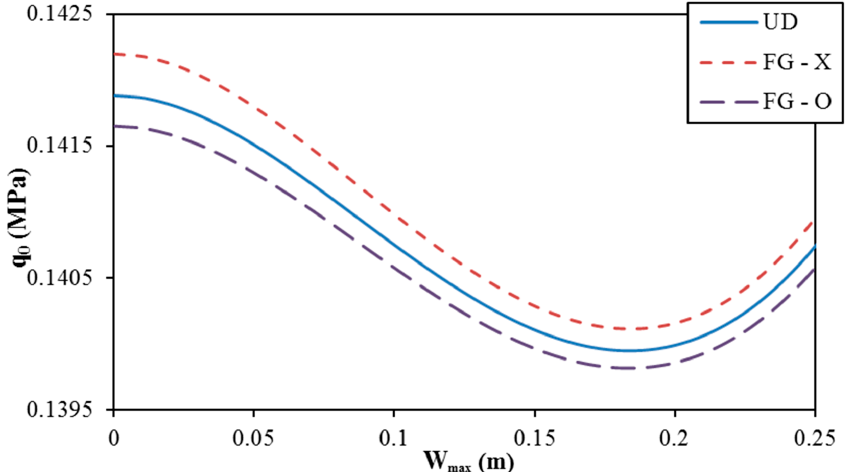
Figure 2. E ff ect of carbon nanotube (CNT) reinforcement type on the postbuckling curve of ring corrugated cylindrical shells (trapezoidal corrugation, V ∗